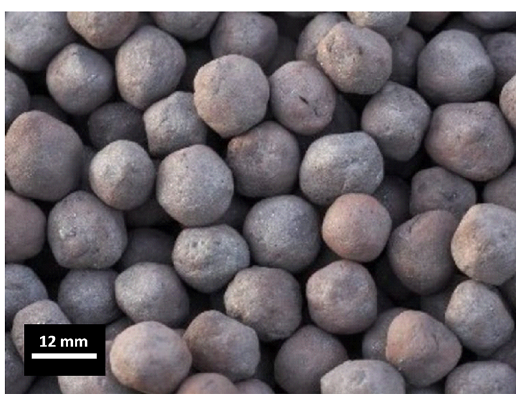
Figure 1. Iron ore